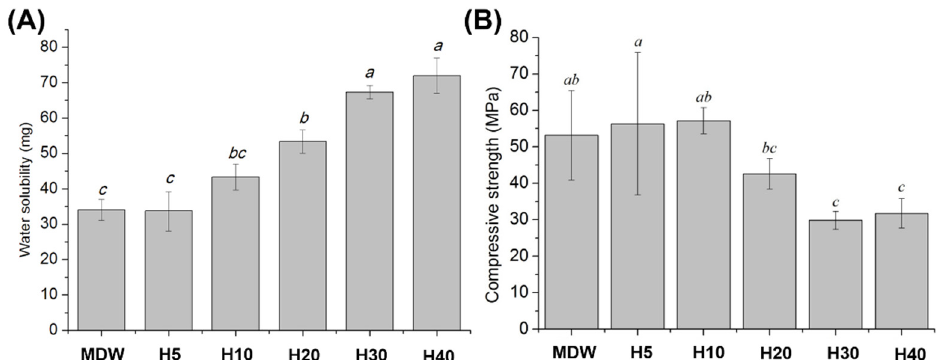
Figure 3. The physical and mechanical properties of control and experimental groups: ( A ) water solubility; ( B ) compressive strength. The F127 concentration showed opposite relationships with water solubility and compressive strength. Different small case letters indicate statistically significant differences between the groups with analysis of variance and Tukey’s post-hoc.